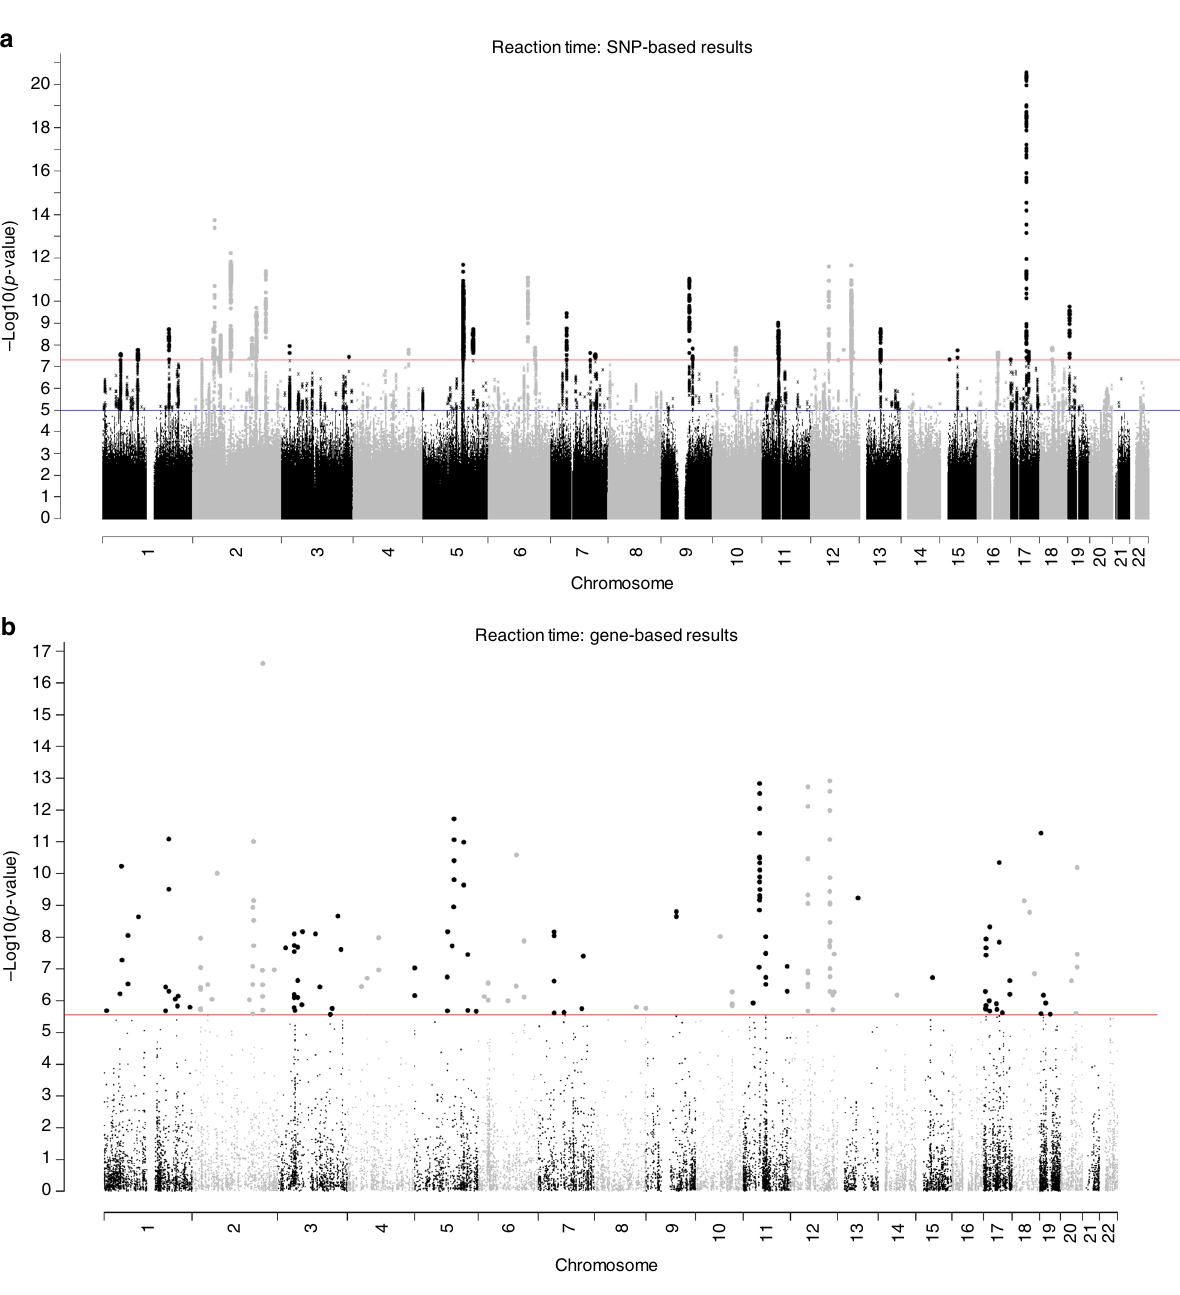
Fig. 4 Association results for reaction time. SNP-based ( a ) and gene-based ( b ) association results in 330,069 individuals. The red line indicates the threshold for genome-wide signi fi cance: P < 5 × 10 − 8 for ( a ), P < 2.75 × 10 − 6 for ( b ); the blue line in ( a ) indicates the threshold for suggestive signi fi cance: P < 1 × 10 −